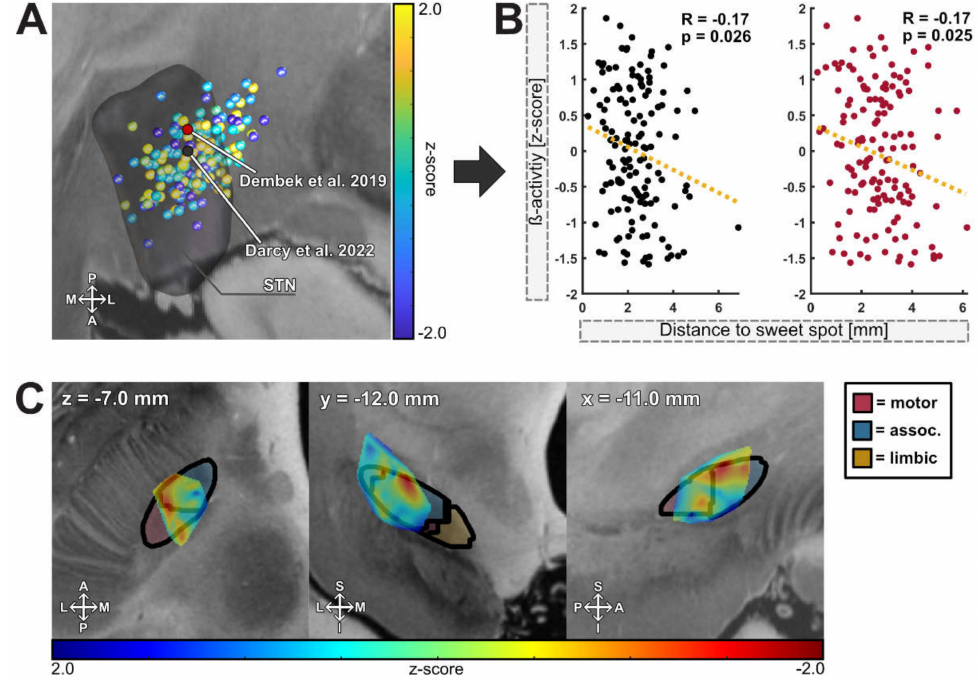
Figure 5. Spatial localization of beta activity: ( A ) Point cloud of beta activity distribution in common MNI space (left hemisphere). The coordinates are color-coded according to z-scored beta activity. The coordinate of the center of gravity of the anatomical sweet spot is depicted as a red dot (Dembek et al. 2019), and the center of gravity of the electrophysiological sweet spot is depicted as a black dot (Darcy et al. 2022). M = medial; L = lateral; S = superior, I = inferior. ( B ) Scattered activity values were correlated with their distance from the center of gravity of the anatomical (red) and electrophysiological sweet spots (black) of the left hemisphere (black; n = 140 contacts). ( C ) Peak values of beta activity in relation to subdivisions of the STN (Accolla et al. 2014). From left to right: axial (z), coronal (y) and sagittal (x) view. A = anterior; P = posterior; L = lateral; M = medial; S = superior, I =